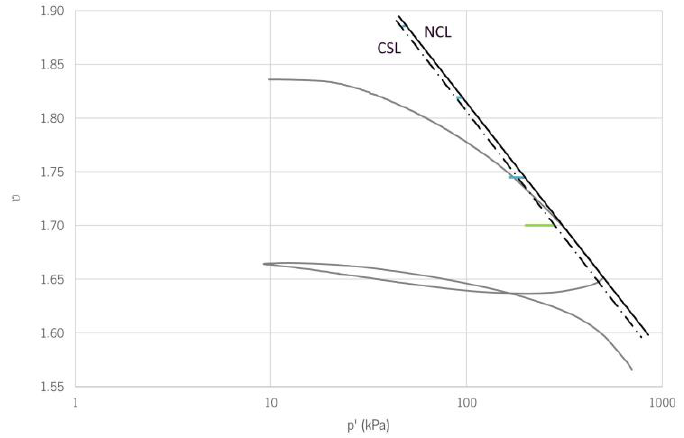
Figure 10. Isotropic consolidation curve with respective NCL and CSL.